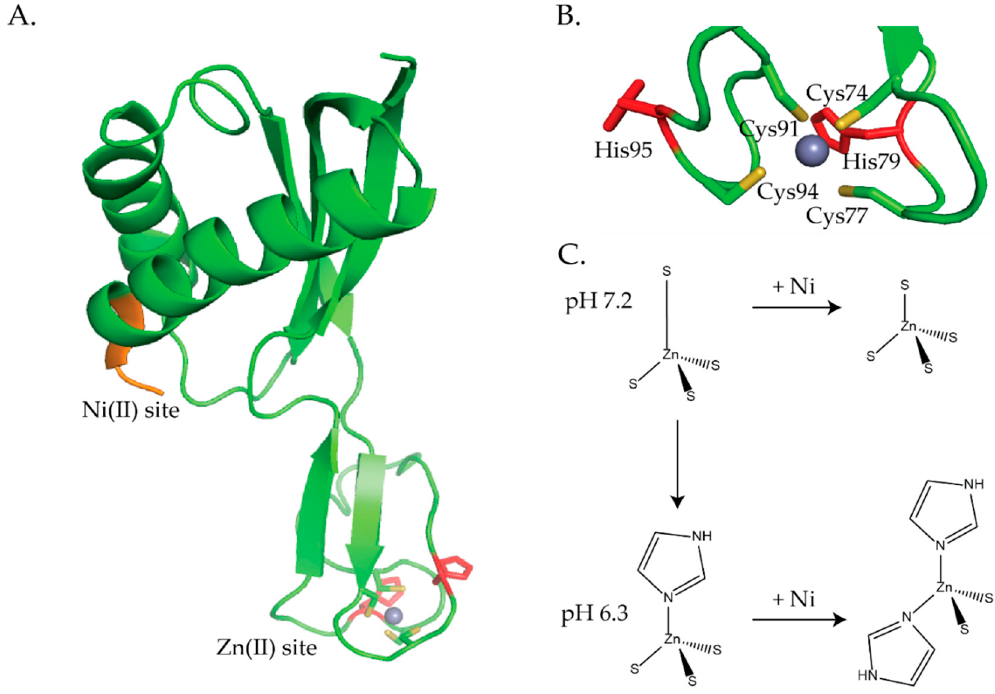
Figure 8. NMR structure of H. pylori HypA at pH 7.2 (PDB ID 6G81) [100]. HypA was expressed in growth medium containing zinc sulphate and purified as ZnHypA [100]. ( A ) The nickel binding MHE residues are in orange and the zinc site is shown at the base of the protein where the